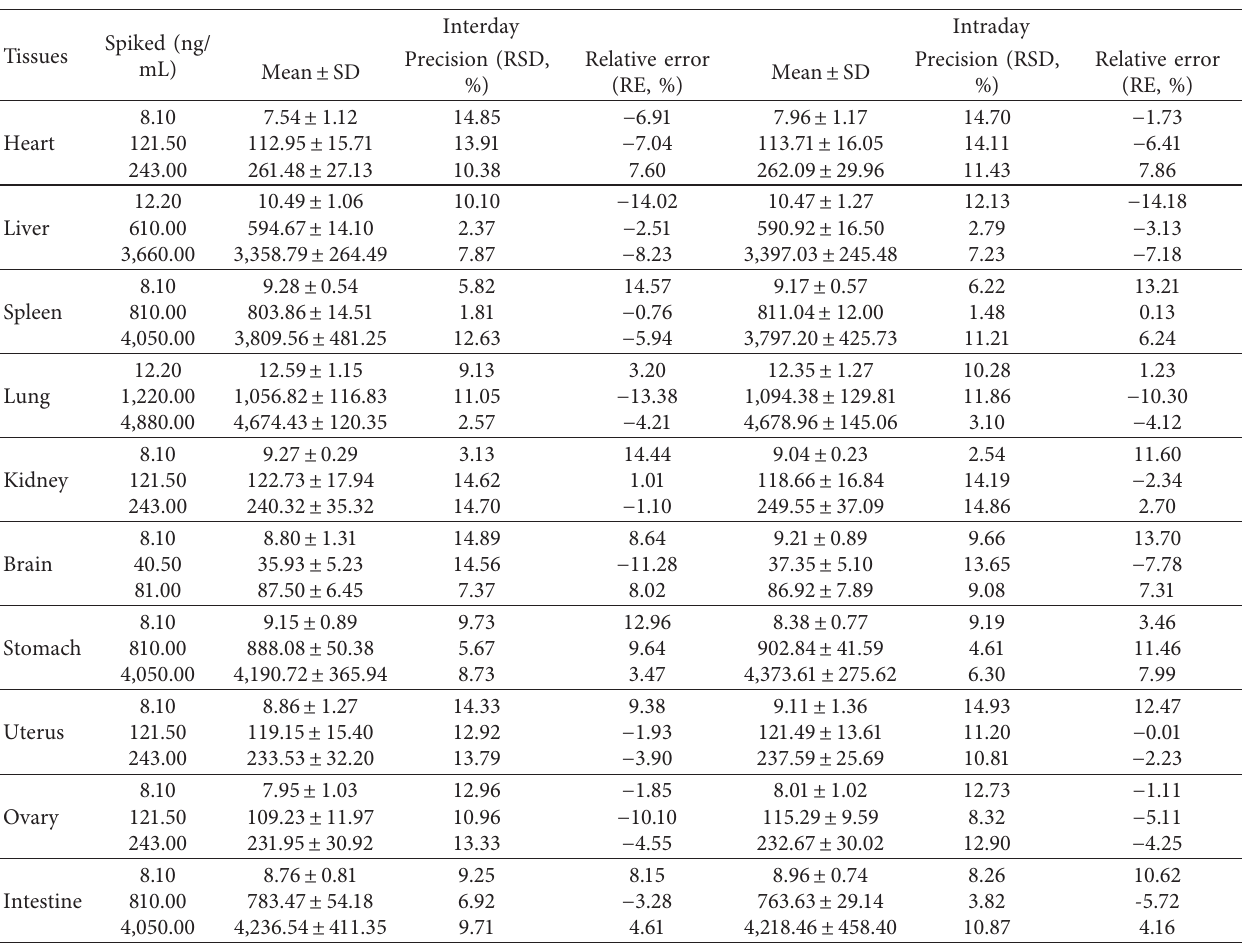
Table 3: Interday and intraday precision and accuracy data for assays of neoeriocitrin in different tissues ( n � 6). Spiked (ng/ Tissues